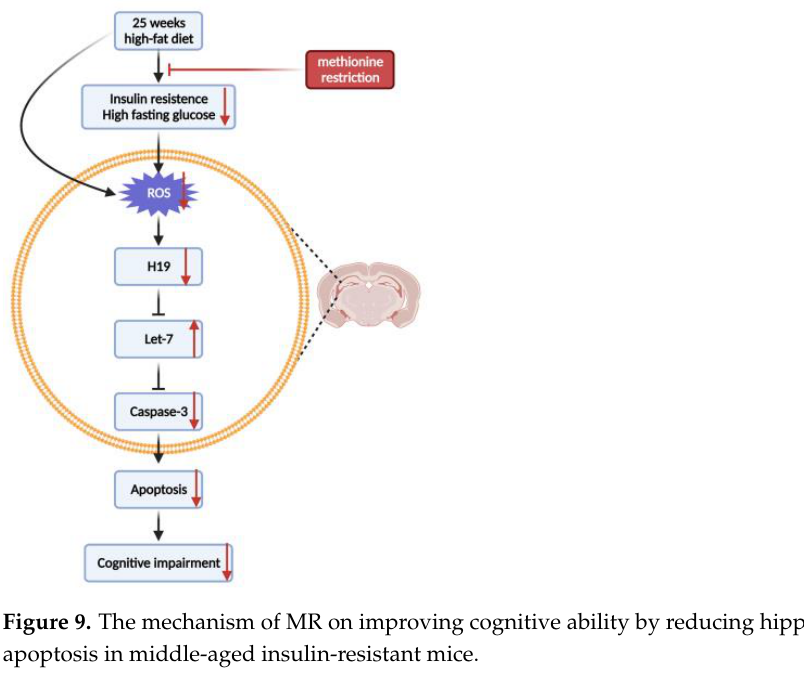
Figure S2. Effects of MR on learning and memory function-related mRNA in the hippocampus of HFD insulin-resistant